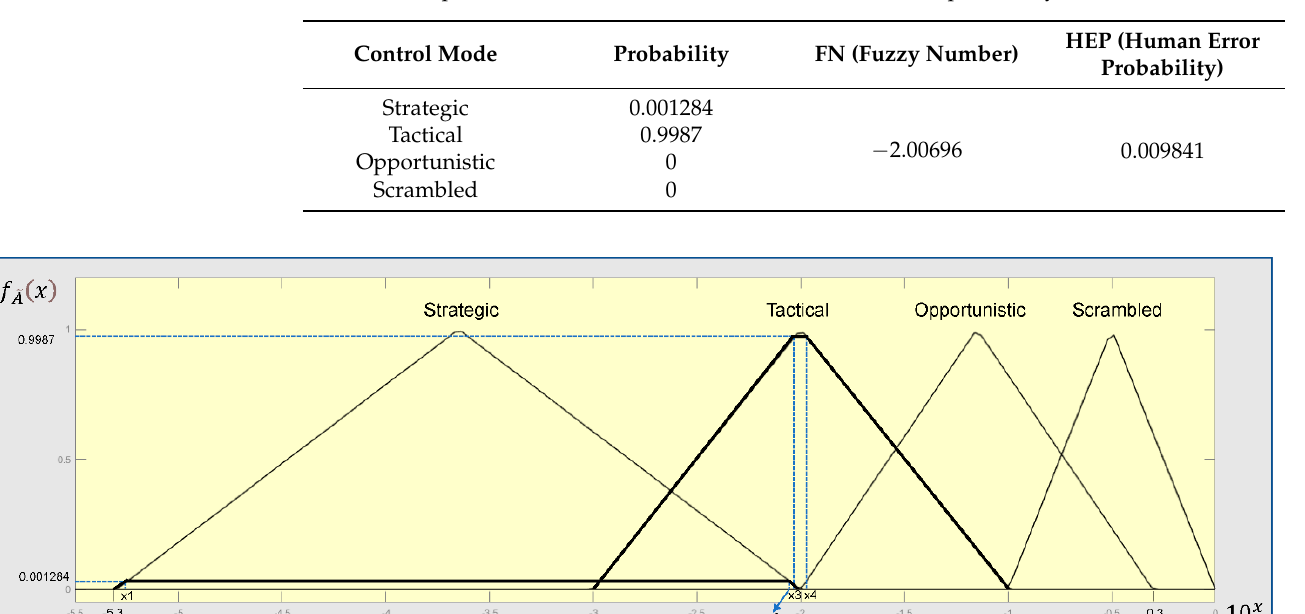
Table 10. The probabilities of the COCOMs and the human error probability (HEP).